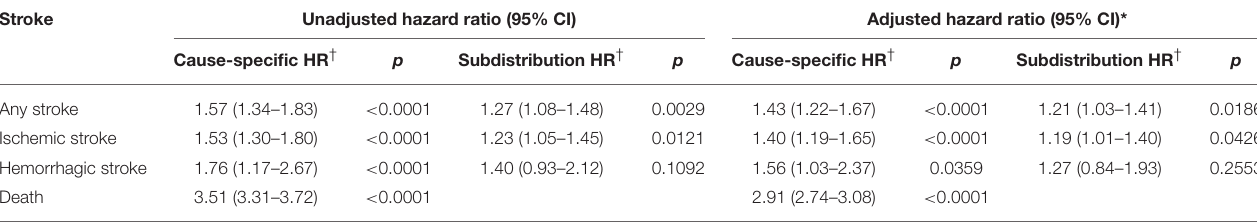
TABLE 5 | Effects of chemotherapy on the risk of stroke in patients with cancer. Stroke Unadjusted hazard ratio (95%